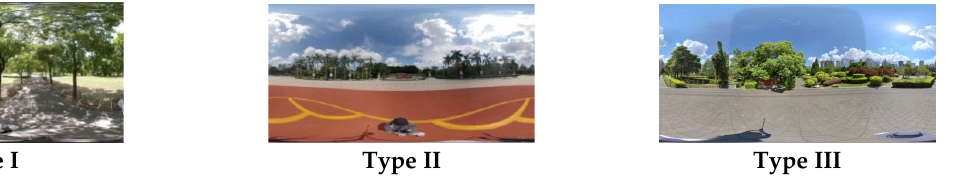
Figure 5. The panoramic view of three types of morning points. Table 3. Regression model between thermal environment and landscape spatial